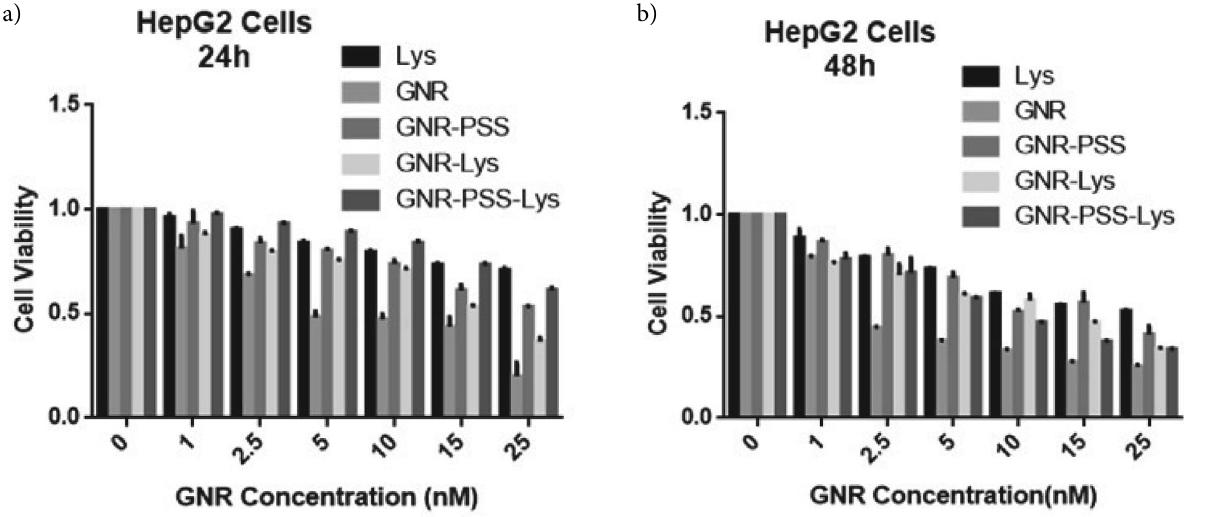
Figure 8. Cell viability assay for HepG2 cell line incubated for 24 h (a) and 48 h (b) with Lys, GNRs, GNRs-PSS, GNRs-Lys and GNRs-PSS-Lys. The abbreviation Lys represents Lysozyme Amyloid Fibrils.